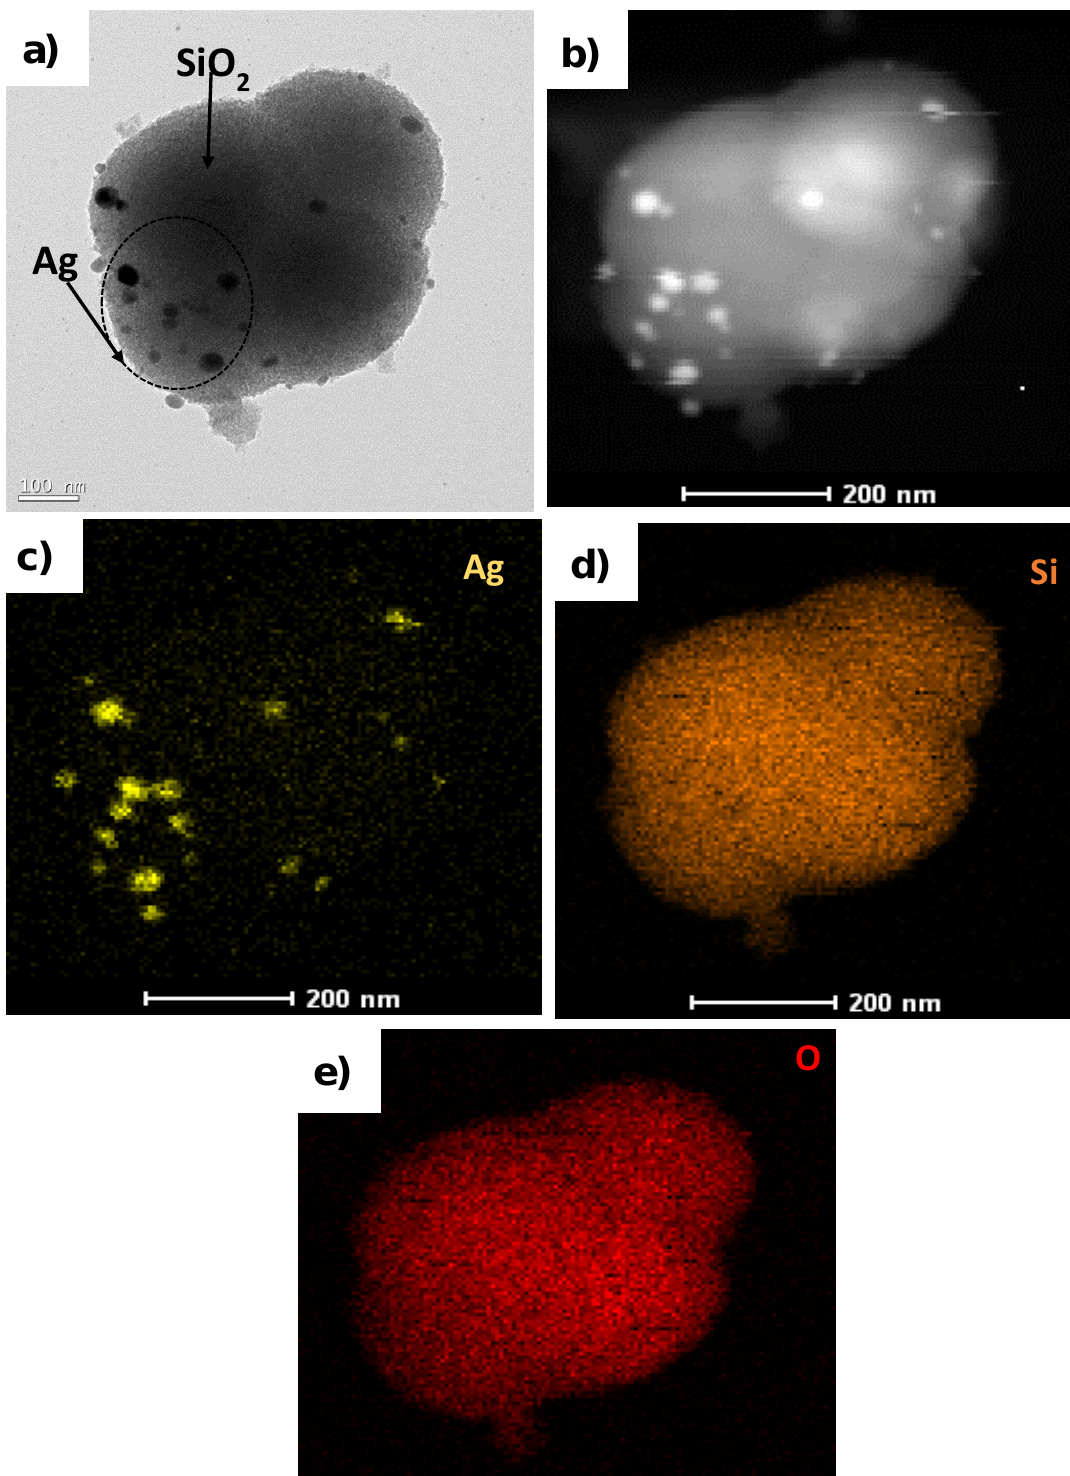
Figure 2. ( a ) Transmission electron microscopy (TEM) image of Ag@SiO 2 , ( b ) high-angle annular dark-field (HAADF) image of Ag@SiO 2 , and EDX mapping of ( c ) Ag, ( d ) Si, and ( e )